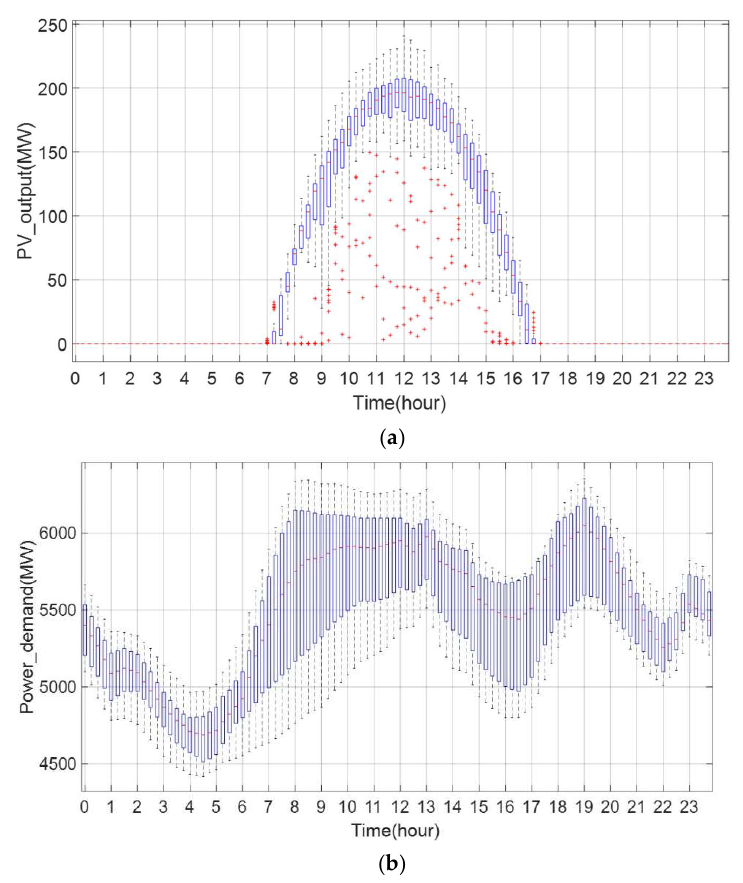
Figure 8. ( a ) Boxplot of daily solar generation, and ( b ) boxplot of daily load curve.